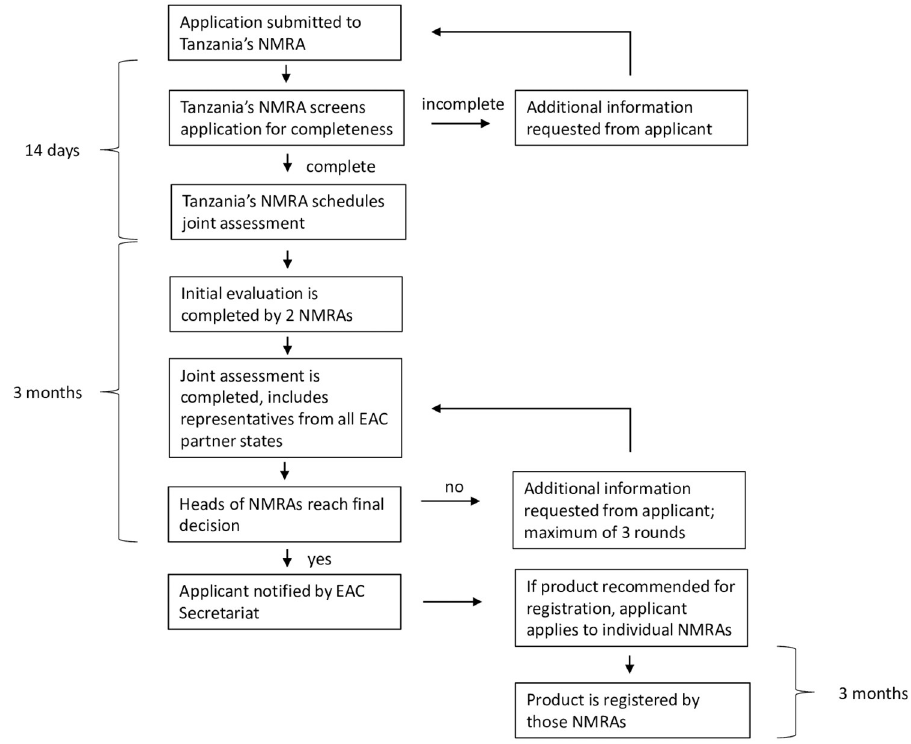
Fig 2. The joint product assessment pathway of the EAC’s Medicines Regulatory Harmonization initiative. EAC, East African Community; NMRA, national medicines regulatory authority.